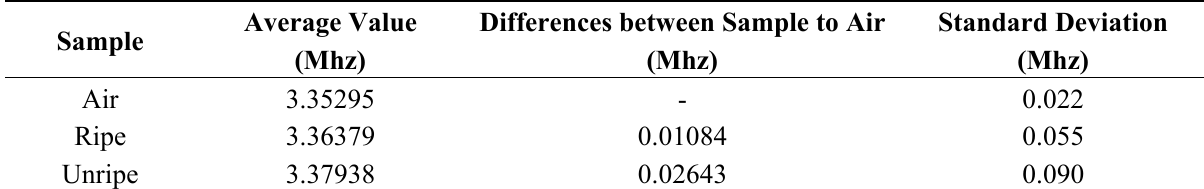
Table 5. Average value and difference between sample to air in coil diameter